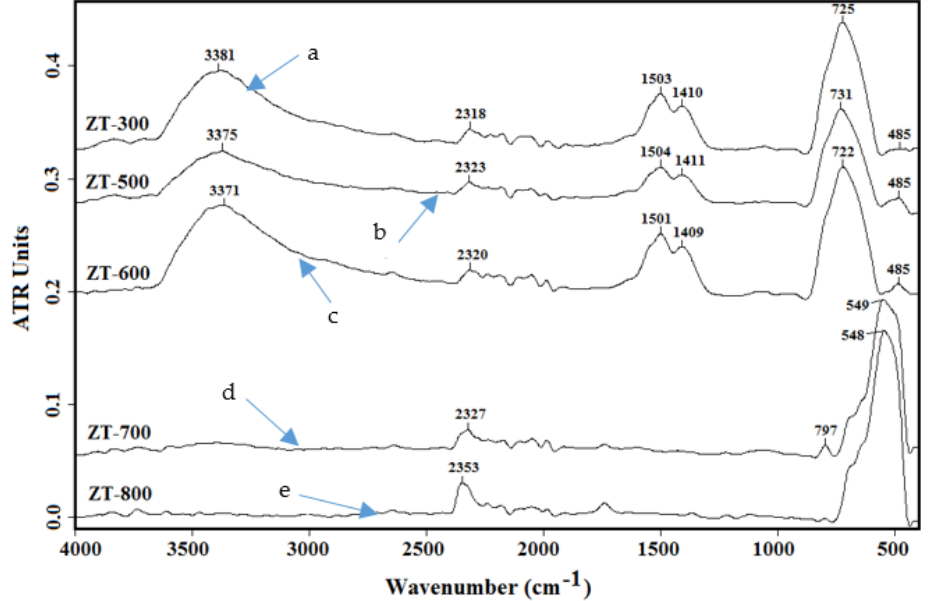
Figure 4. Fourier transform infrared (FT–IR) spectra of synthetized composites: ( a ) ZT-300, ( b ) ZT-500, ( c ) ZT-600, ( d ) ZT-700, ( e ) ZT-800.